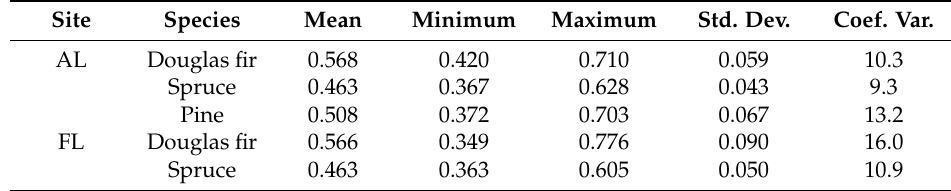
Table 2. Wood density (in g · cm − 3 ) of individual tree species according to the evaluated sites.